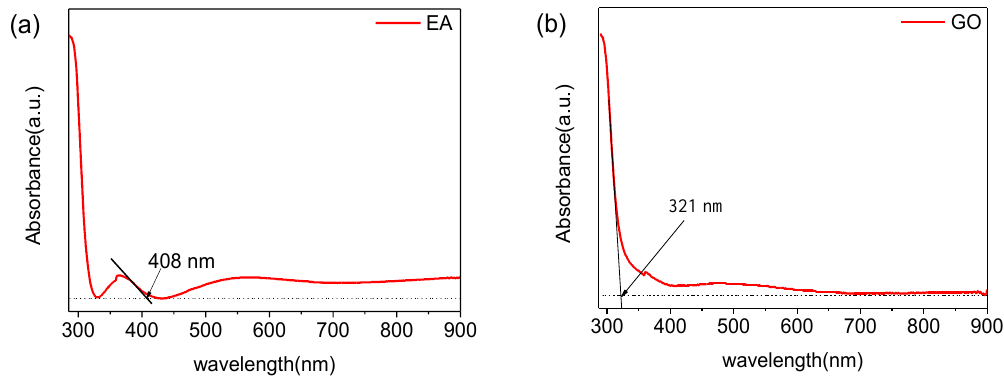
Figure 4. UV–Vis spectra of ( a ) the EA film and ( b ) the GO film.